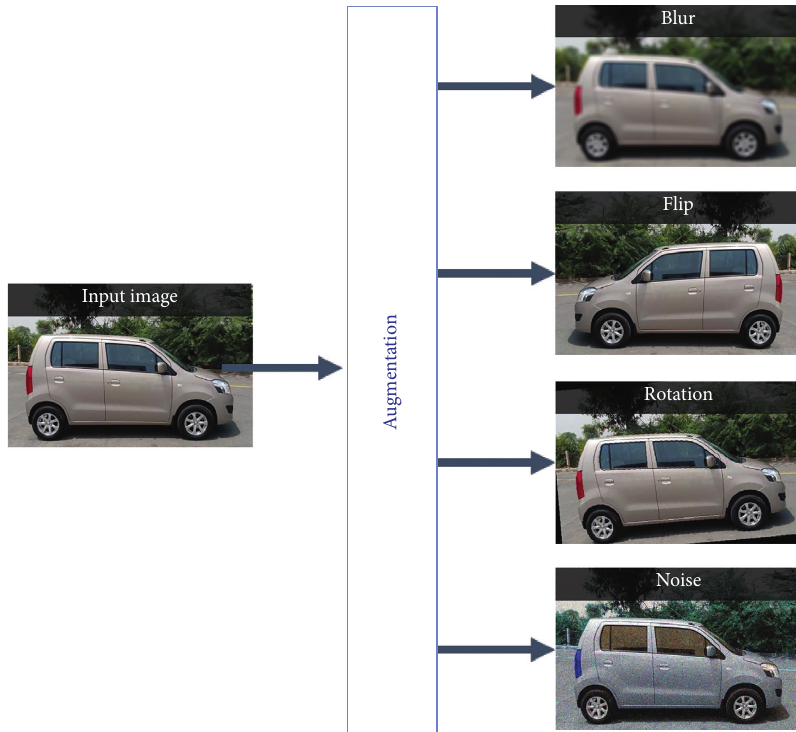
Figure 3: Data augmentation performed on the dataset